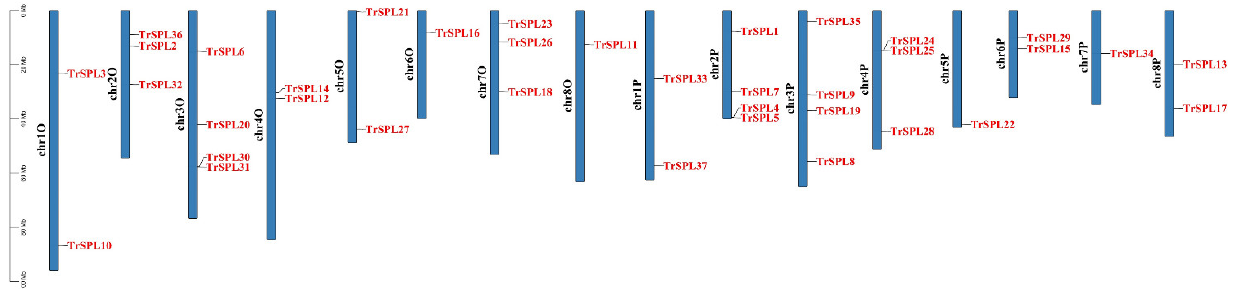
Figure 5. Distribution of TrSPL genes on chromosomes. The leftmost scale shows the length of chromosomes. Chromosomes are represented by blue bars.